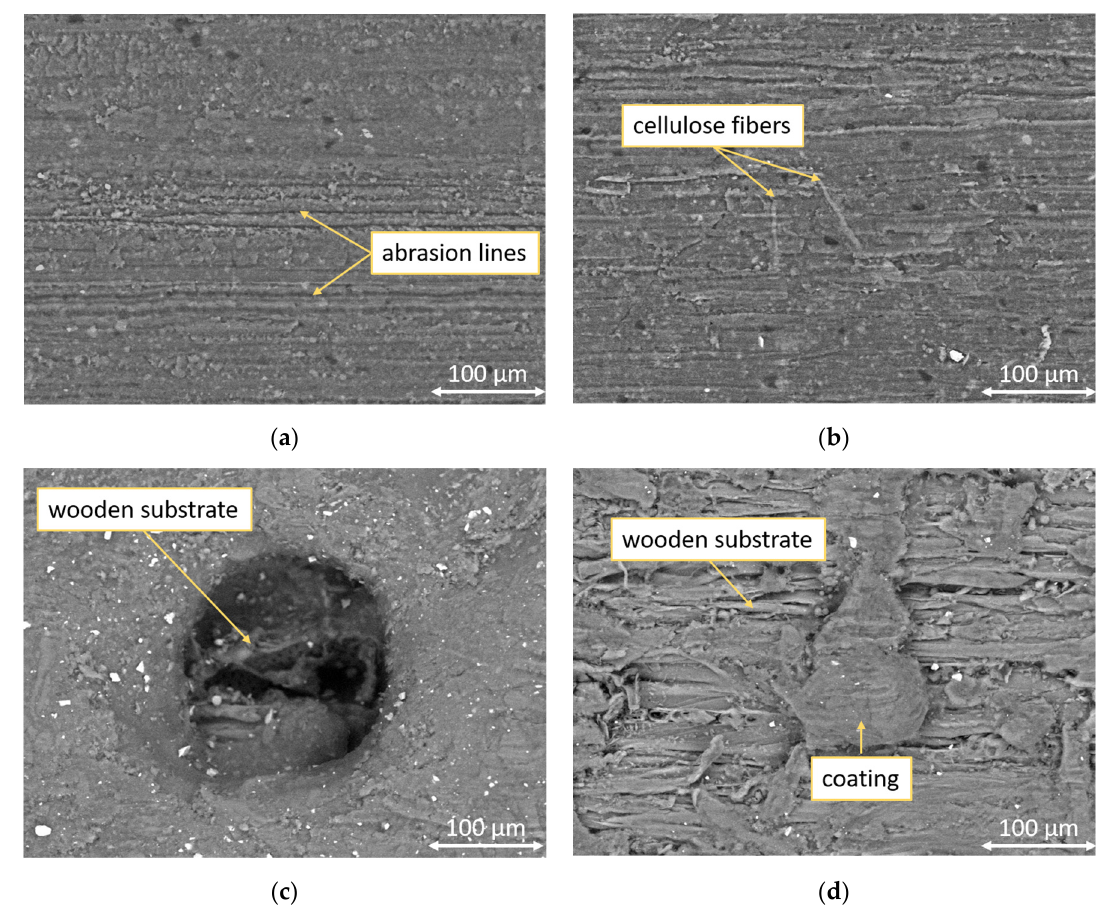
Figure 13. Top-view SEM micrographs of the surface morphology of ( a ) sample F0, ( b ) sample F5, ( c ) sample F10 and ( d ) sample F20 after the 1000 scrub test cycles.